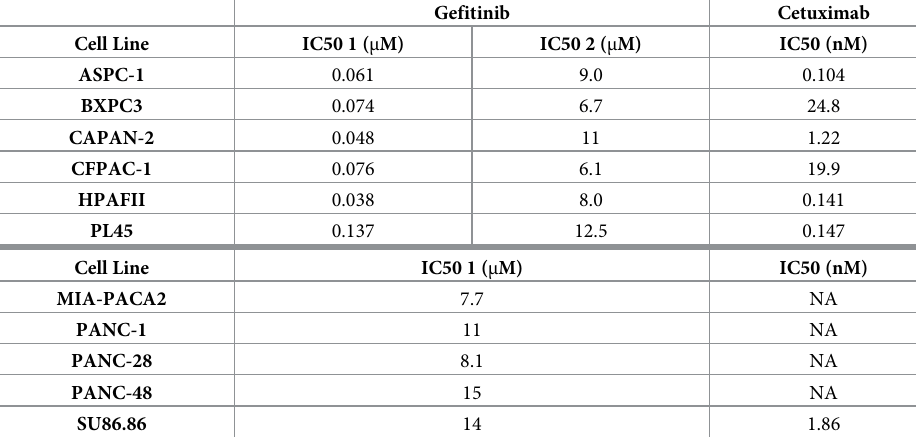
Table 1. PDAC IC50 when treated with gefitinib or